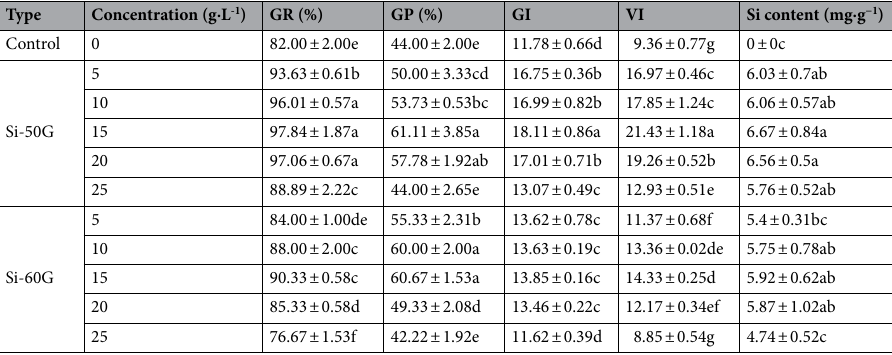
Table 1. Effects of the Si (5, 10, 15, 20, and 25 g·L −1 ) on germination indices. The values represent the mean ± SE (n = 5). Values with the same letters in the columns are not significantly different at P < 0.05.